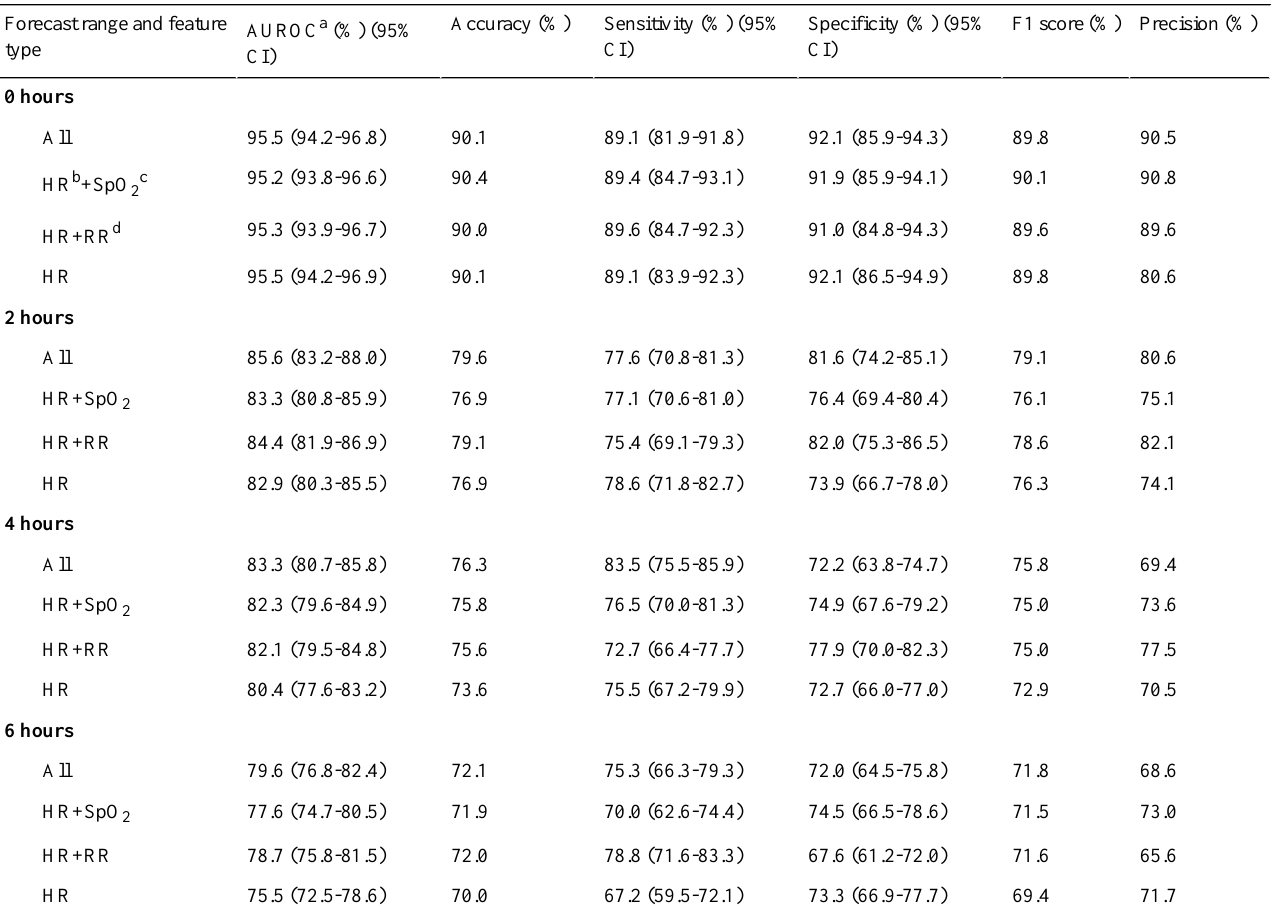
Table 4. Performance of TOP-Net with the different types of